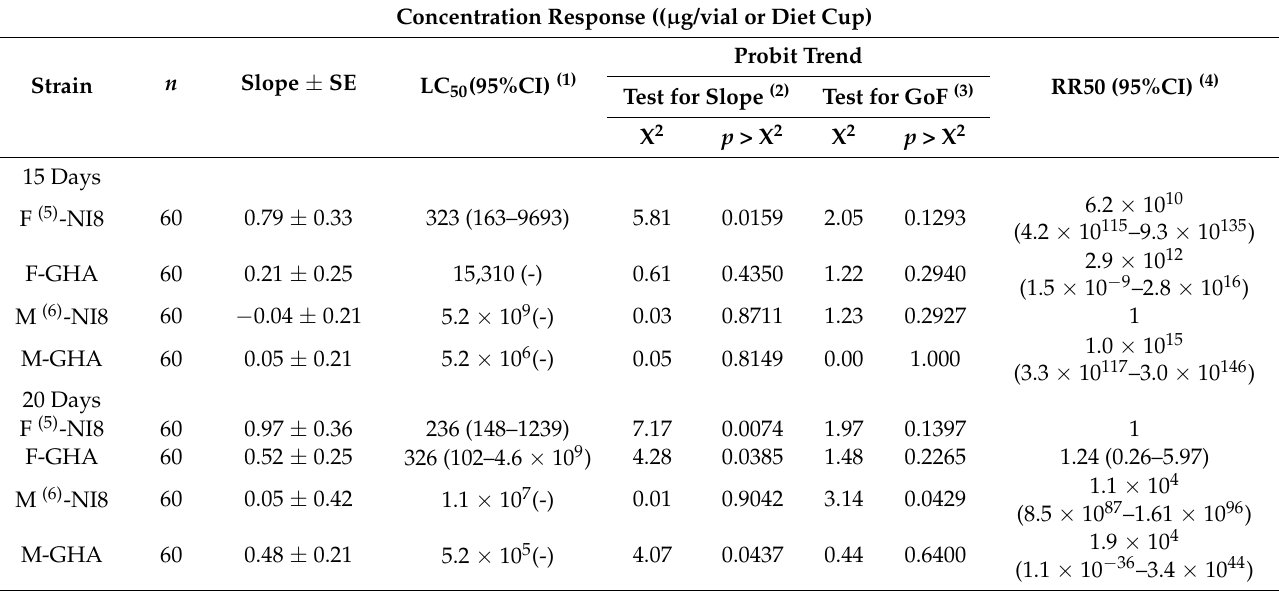
Table 1. Lethal mortality response (LC 50 ) of Nezara viridula female and male treated with 2 different strains of Beauveria bassiana , native NI8 and commercial